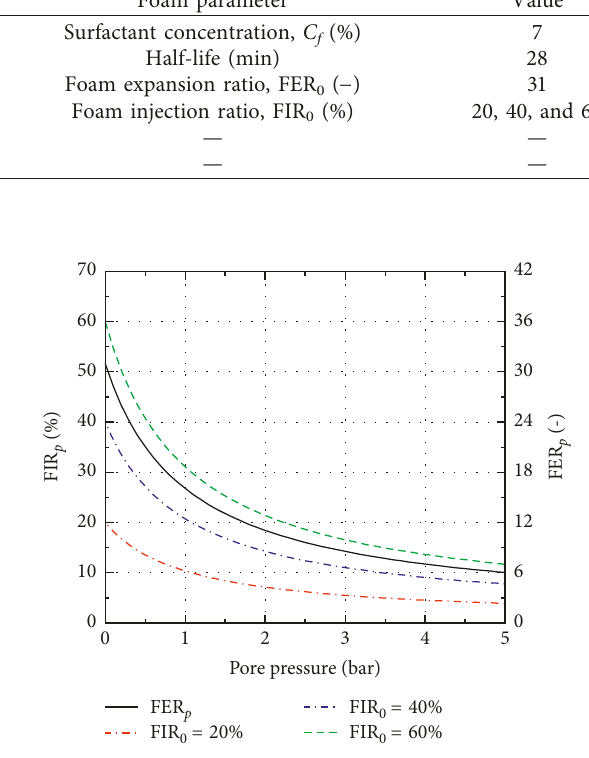
Figure 5: Variations of the foam FIR